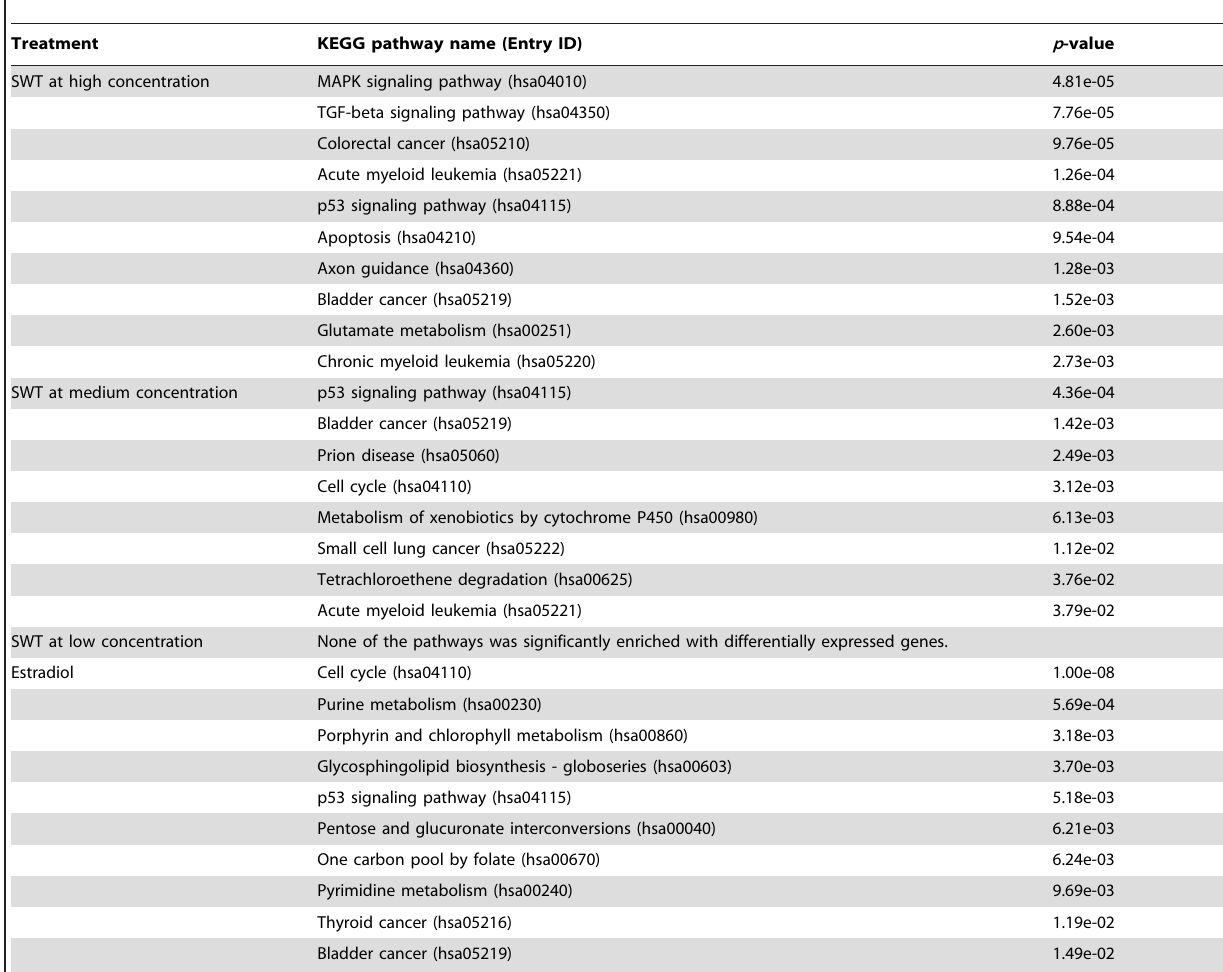
Table 3. Top KEGG pathways enriched with differentially expressed genes and their corresponding Fisher’s exact test p values.